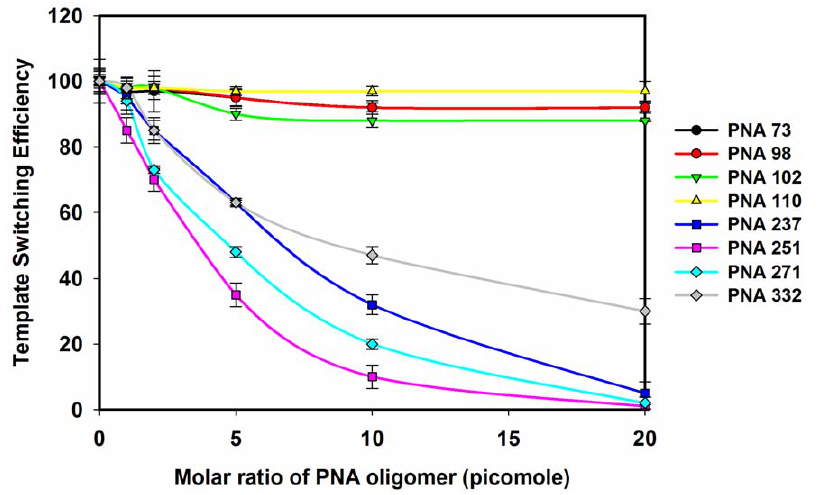
Figure 9. Effects of PNA on the template-switching efficiency between the acceptor and donor HIV-1 RNA templates. The RNA samples from the coupled dimerization-template switching experiments were analyzed on the 6% TBE denaturing gels and the intensity of bands corresponding to the template-switched products and the full-length product of the donor on each gel was quantified The template-switching efficiency for each sample was calculated as t/T 6 100%, where ‘t’ is the % intensity of template-switching product in the primer extension reaction with different concentration of PNA oligomer and ‘T’ is the % intensity of the template-switching product in the primer extension reaction without PNA oligomers. Error bars indicate standard deviation of triplicate runs.